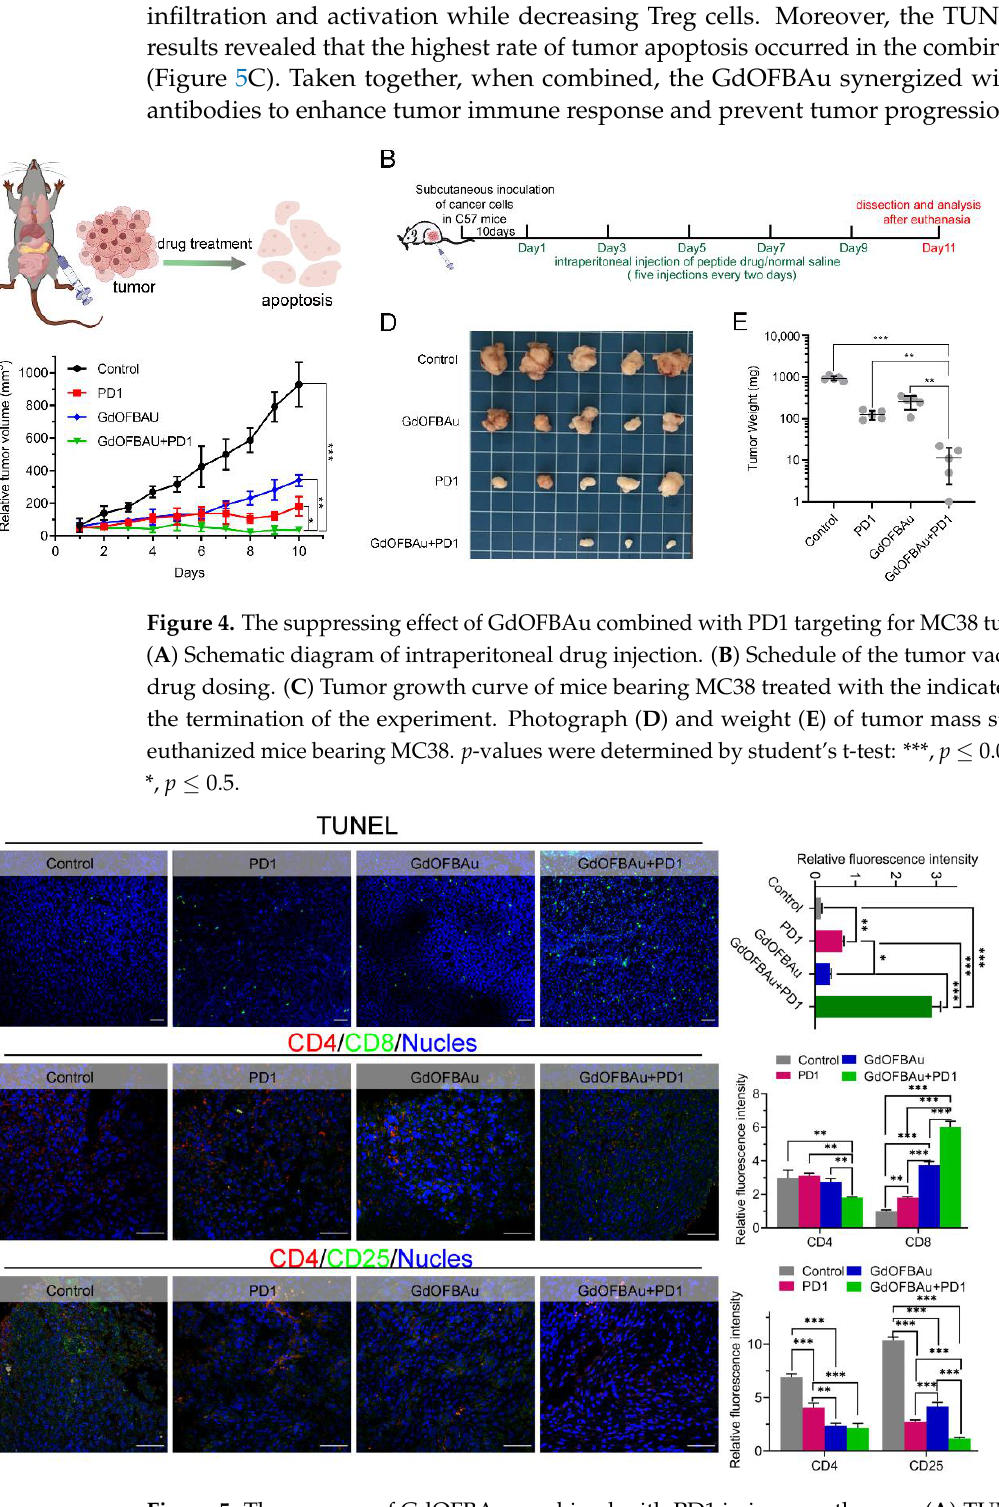
Figure 5. The synergy of GdOFBAu combined with PD1 in immunotherapy. ( A ) TUNEL staining of MC38 tumor mass after five drug administrations. Immunofluorescence of CD4 + /CD8 + ( B ) and CD4 + /CD25 + ( C ) in MC38 tumor after five drug administrations. Scale bar: 50 µm. p -values were determined by student’s t -test: *** , p ≤ 0.05; ** , p ≤ 0.1; * , p ≤ 0.5.